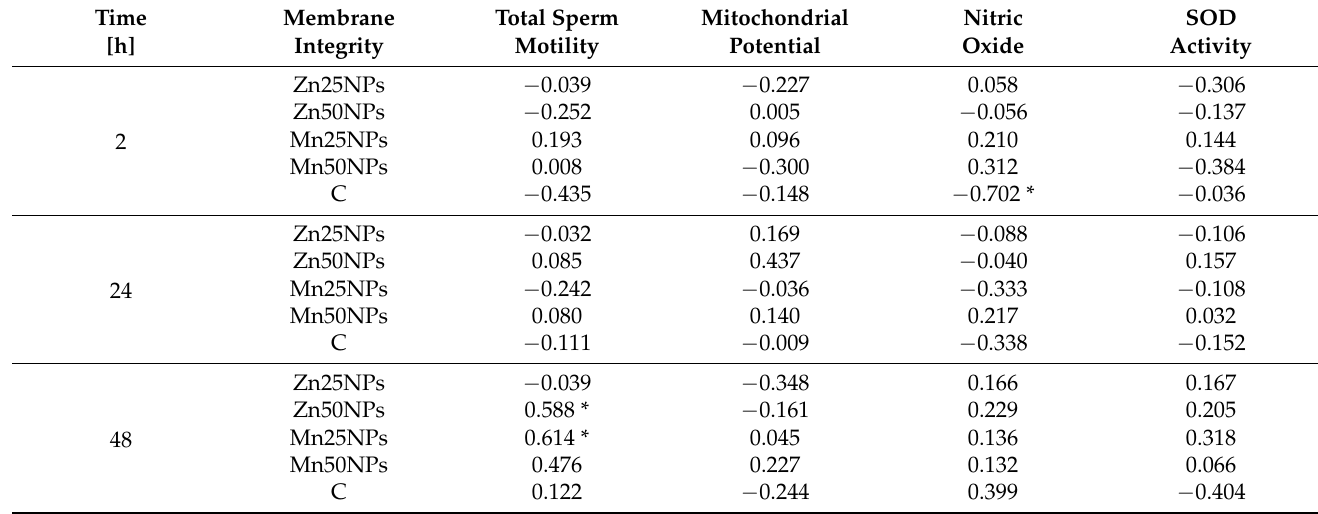
The correlations between sperm motility and high MMP were maintained in samples containing Mn25NPs and in control samples after 48 h of storage (Table 2). The strongest correlation was observed in sperm preserved with Mn25NPs. The strongest correlation between motility, plasma membrane integrity and SOD activity, was also noted in samples containing Mn25NPs ( p ≤ 0.05). Surprisingly, significant correlations between sperm motility and NO production were found only in samples with ZnNP supplementation (Table 2). After 2 h of storage, sperm membrane integrity was negatively correlated with the percentage of sperm that generated NO ( p ≤ 0.05) in control samples (Table 3). The negative correlation between membrane integrity and the percentage of sperm that generated NO ( p ≤ 0.05) was noted after 24 h of semen preservation (Table 3). In turn, after 48 h of storage correlations between membrane integrity and sperm motility were demonstrated (as described above the Table 2). Table 3. Correlations between membrane integrity and other sperm parameters during the preservation procedure. Time